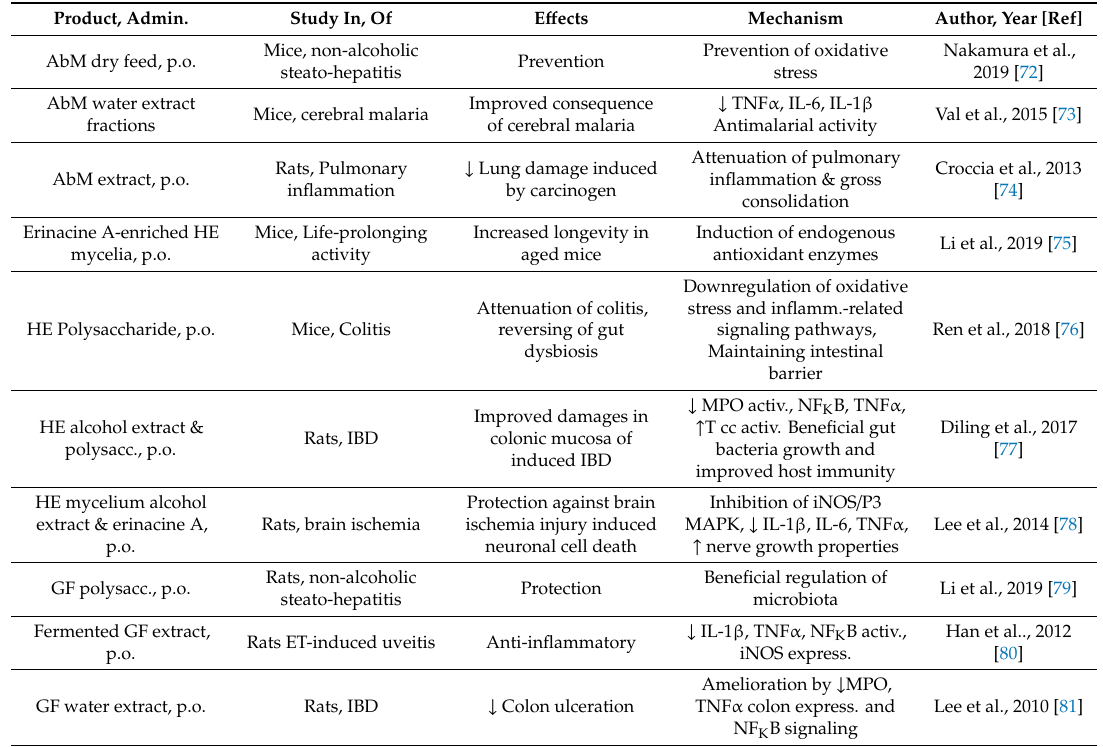
Anti-inflammatory e ff ect of Agaricus blazei Murill, Hericium erinaceus and Grifola frondosa -Preclinical